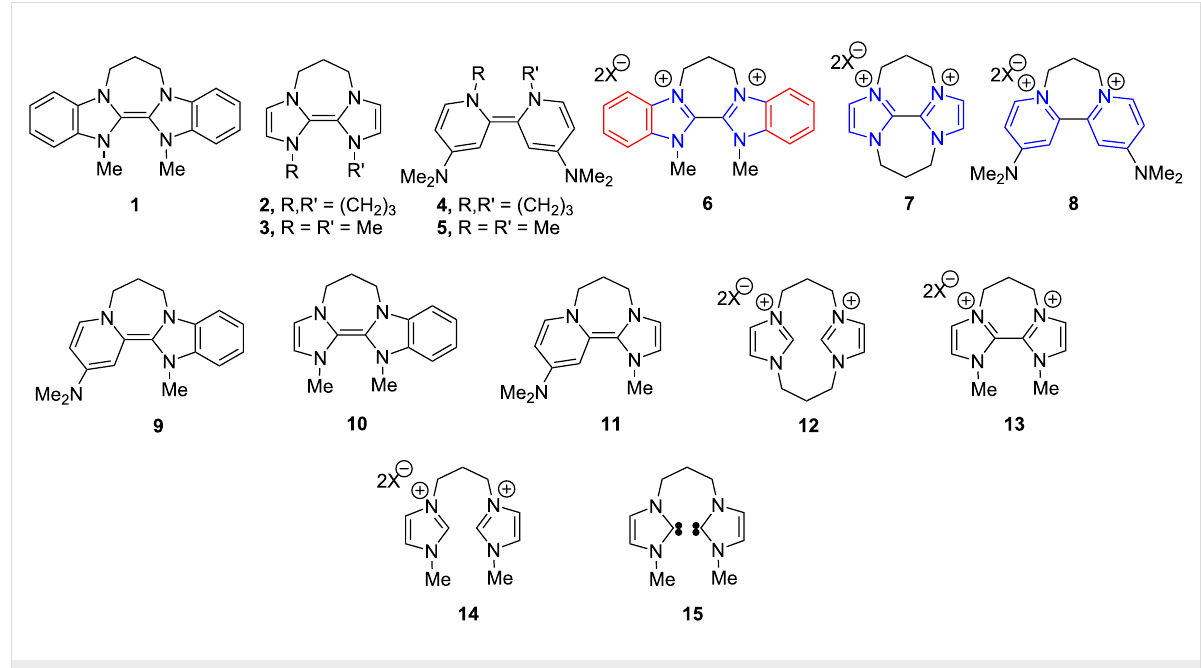
Figure 1: Super-electron-donors and related